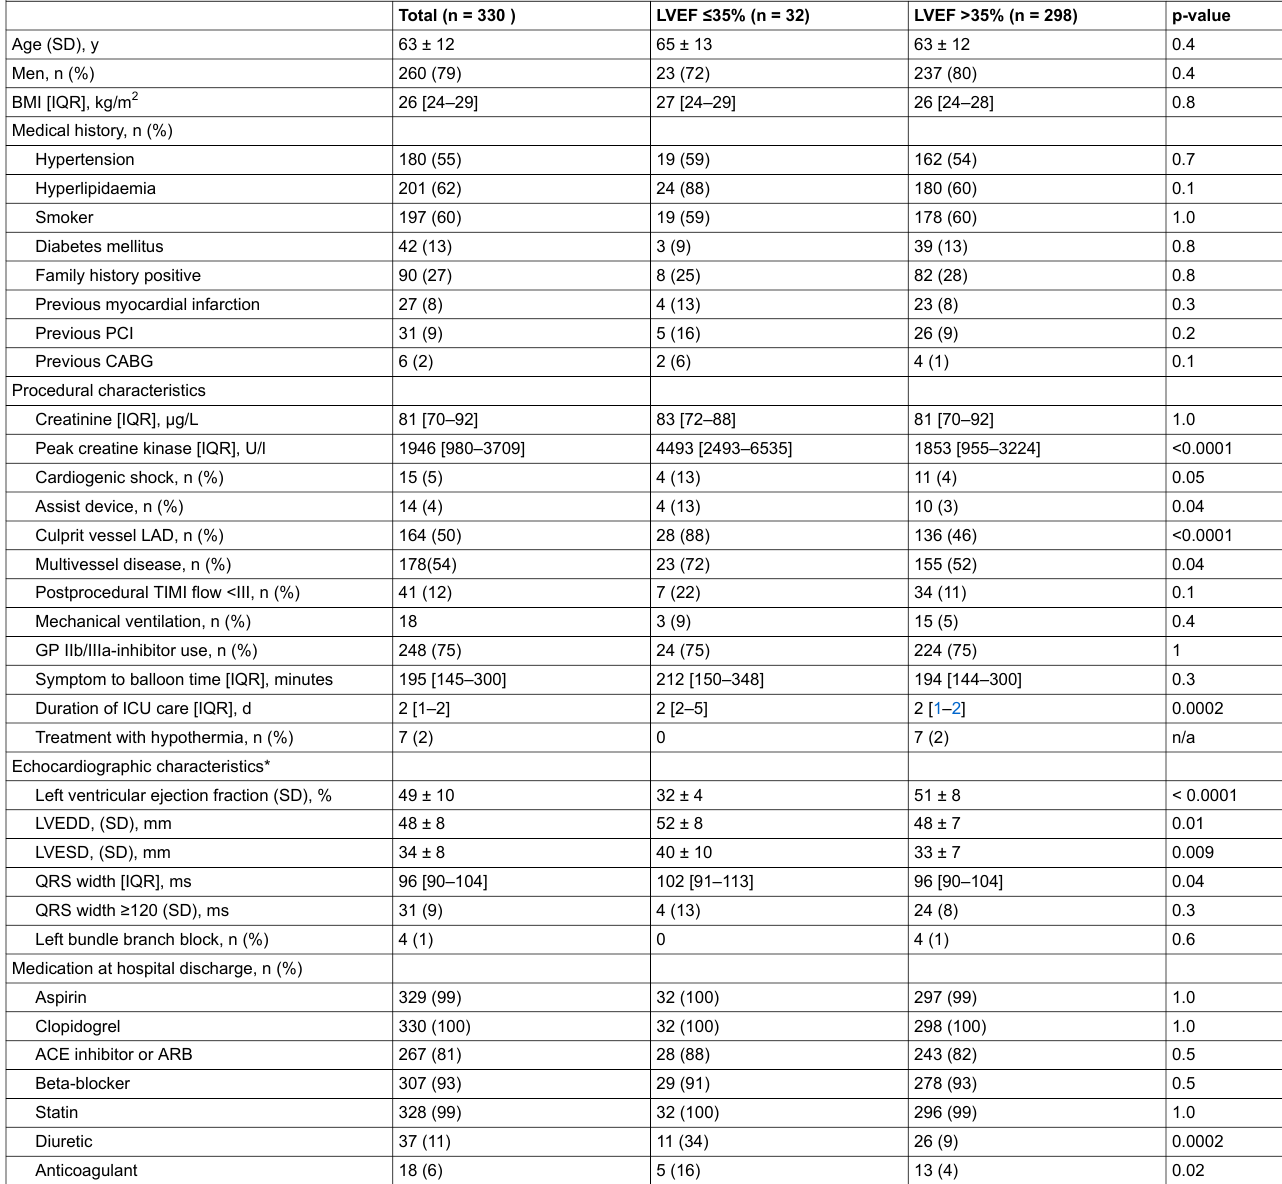
Table 1: Baseline characteristics of the total study population and by in-hospital LVEF ≤35% and >35%. Total (n = 330